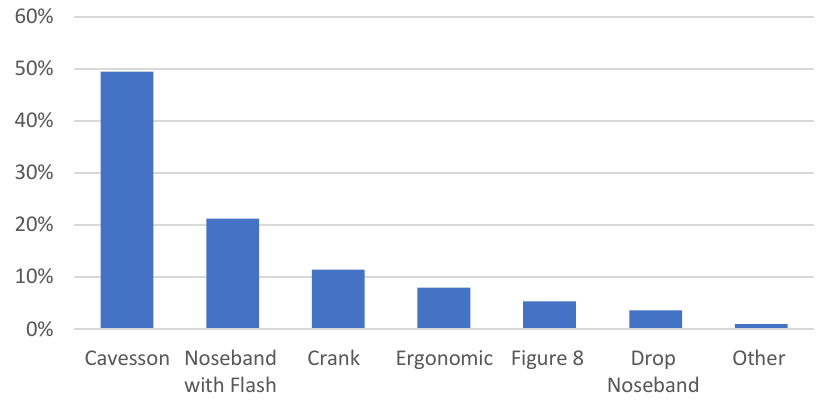
Figure 2. The percentage of different types of nosebands recorded by Pilot Stewards during the 2021 Canadian competition season on a total of 551 horses representing six different equestrian sports. A large majority of the horses passed the two-finger measurement using the ISES noseband taper gauge. Of those horses who did not pass the two-finger measurement, 19.2% (106) passed the one-finger measurement, with 10.0% (5) of horses having nose- bands that were too tight to fit the taper gauge (Figure 3). Six of the 551 horses were unable to be measured due to their volatile responses.